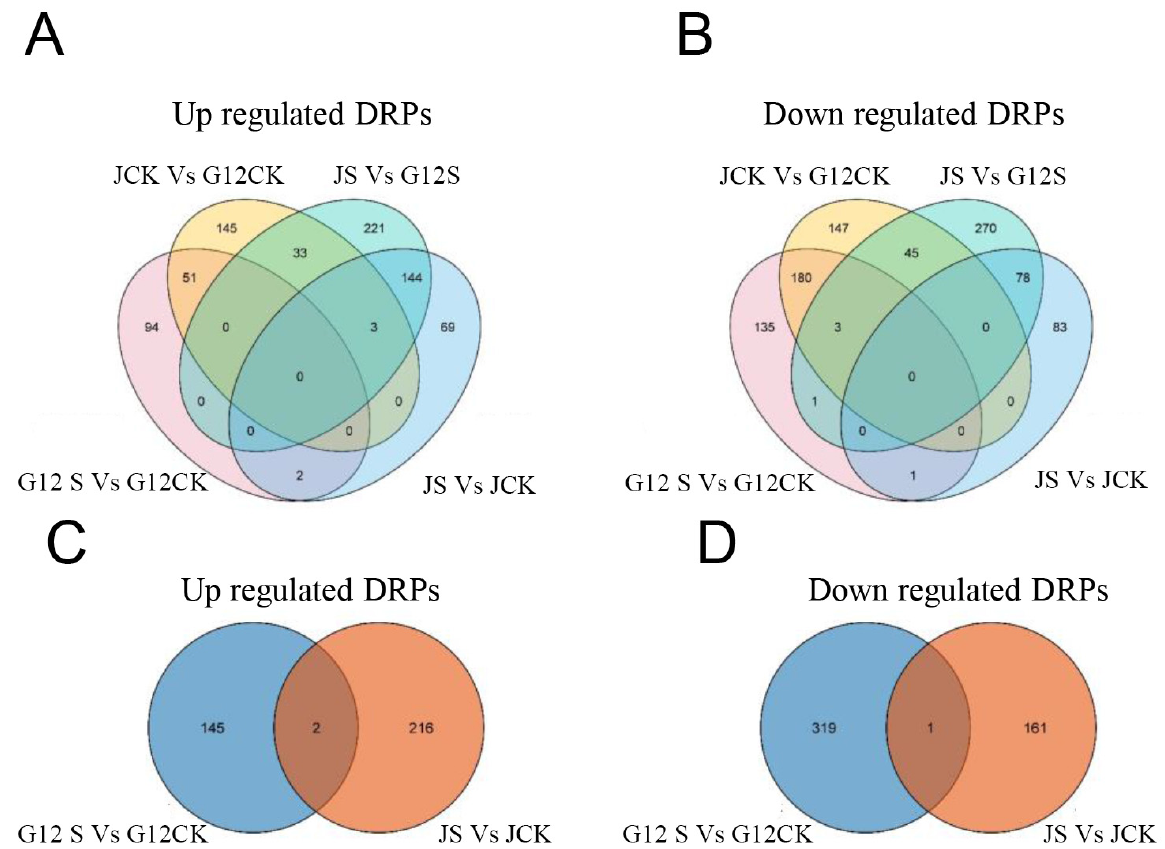
Figure 3. Analysis of Venn diagram. ( A , B ) Venn diagram of differentially expressed proteins identified at different treatments. ( C , D ) Venn diagram of differentially expressed proteins identified between Jisang3 and Guisangyou12 in the saline condition.